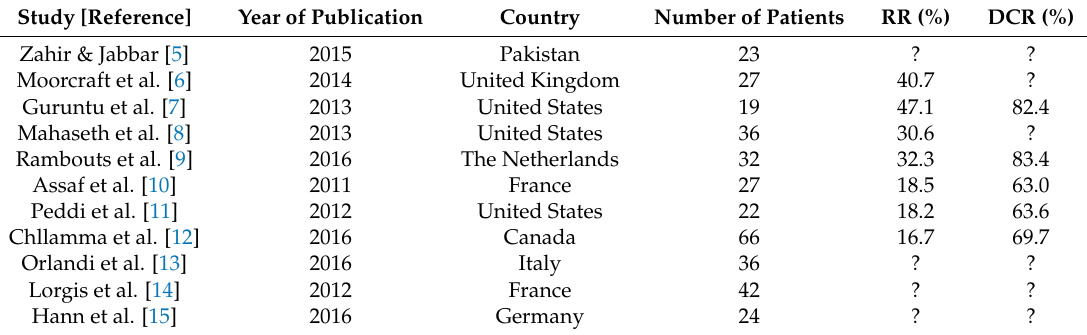
Figure 1. Diagram of the number of studies evaluated for these analyses and the reasons for exclusion. Eleven series and four phase II studies were included and pooled separately. Table 1. Off-trial series included in the pooled analysis of FOLFIRINOX in metastatic pancreatic cancer. The question-mark denotes that the study did not provide a Response Rate (RR) or Disease Control Rate (DCR).